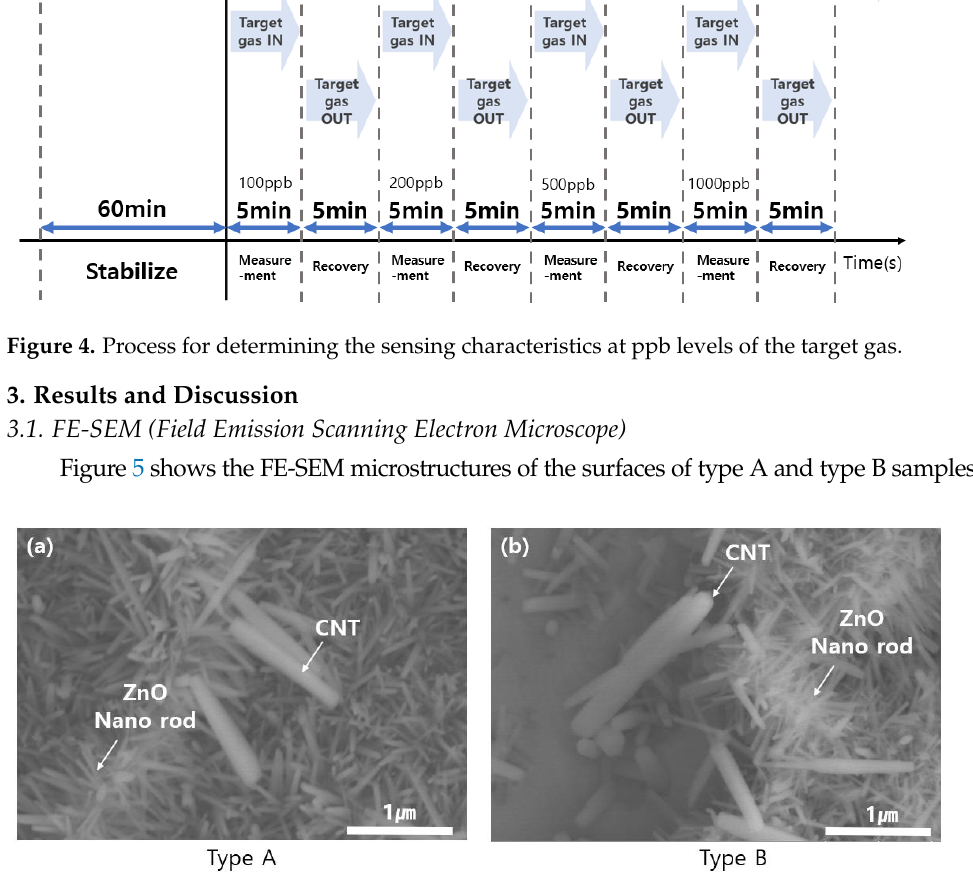
Figure 5. FE-SEM image of samples ( a ) type A ( b ) type B.